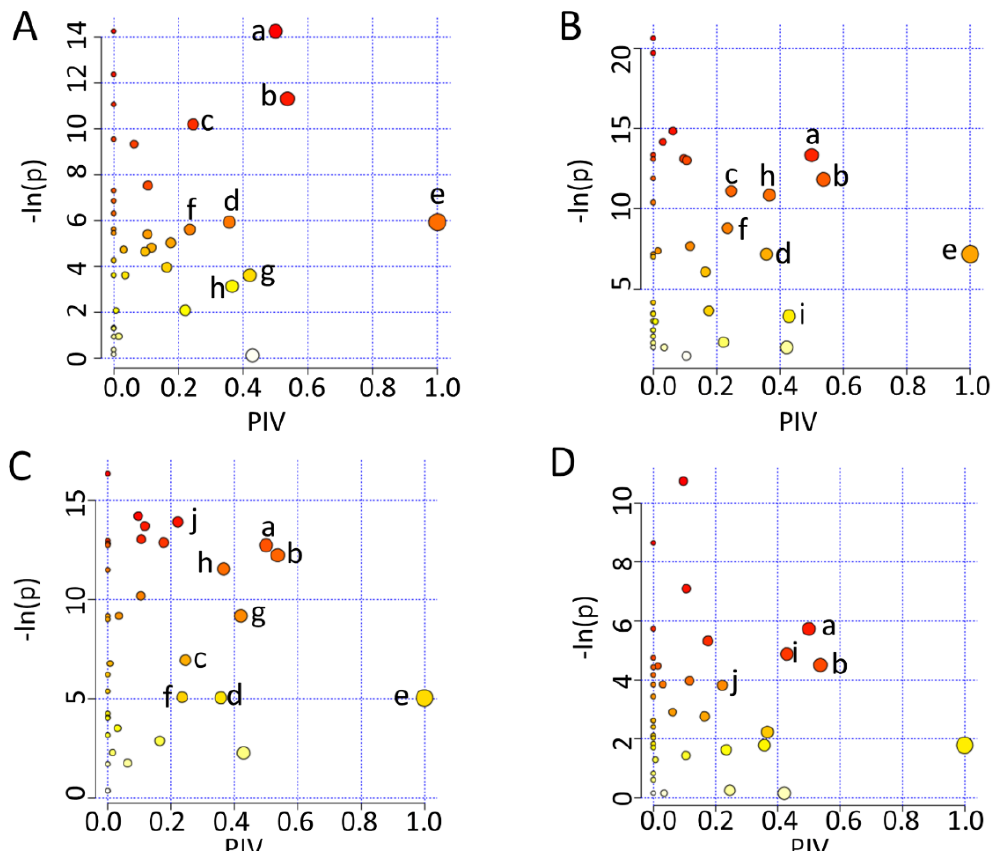
Figure 6. Metabolic pathway analysis. ( A ) Iod10 vs. Ctrl; ( B ) Iod30 vs. Ctrl; ( C ) D ‐ 4F + Iod10 vs. Iod10; and ( D ) D ‐ 4F + Iod30 vs. Iod30 are shown. Significantly altered metabolic pathways were identified using a combination of metabolite sets enrichment analysis ( p < 0.05) and topological pathway analysis (PIV > 0.2) based on the absolute concentrations of metabolites. a: glutamine